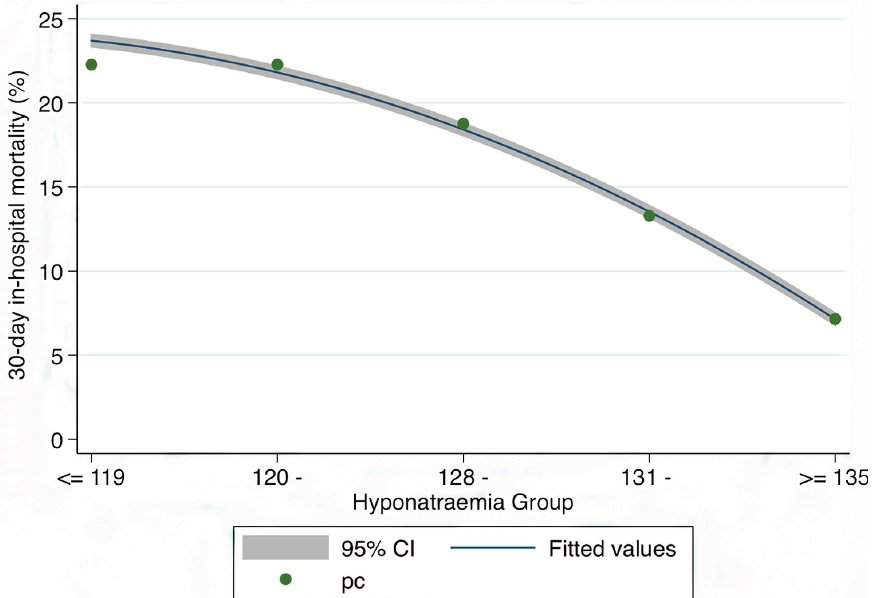
Figure 1. Relationship between 30 days in-hospital mortality and admission sodium